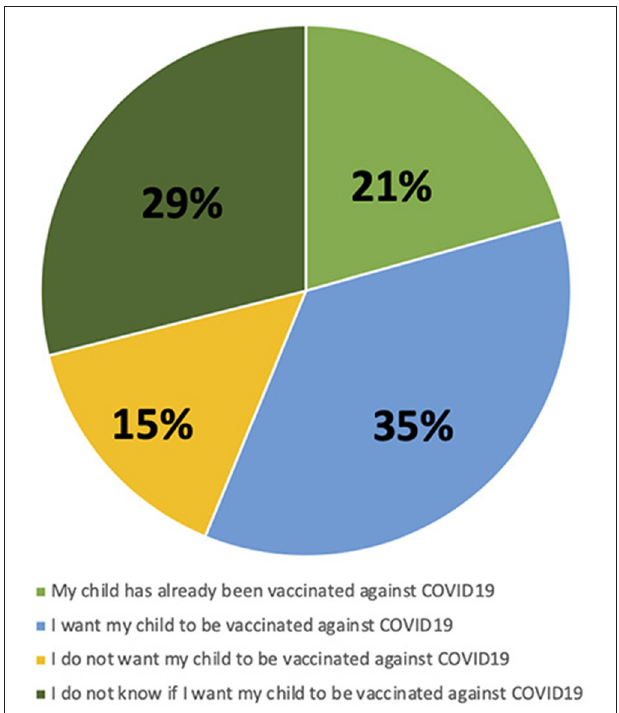
FIGURE 1 | Caregivers’ attitudes toward COVID-19 vaccination of his/her child.